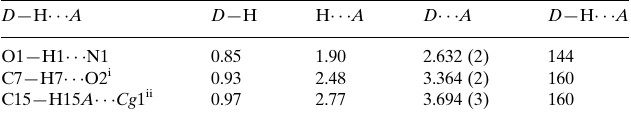
Hydrogen-bond geometry (A˚ , (cid:2) ). Cg 1 is the centroid of the C1–C6